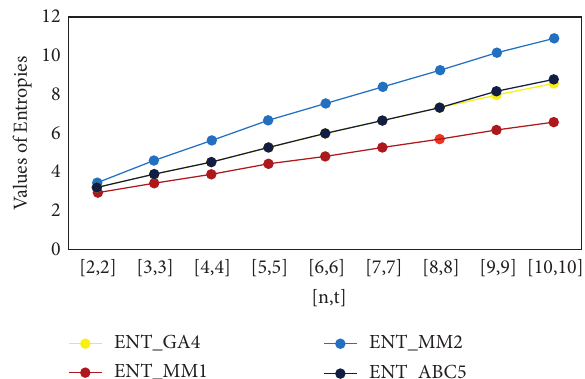
Figure 6: Graphical comparison of eccentricity-based entropies for corona product of hypertree and a path CBT ( t ) ⊙ P